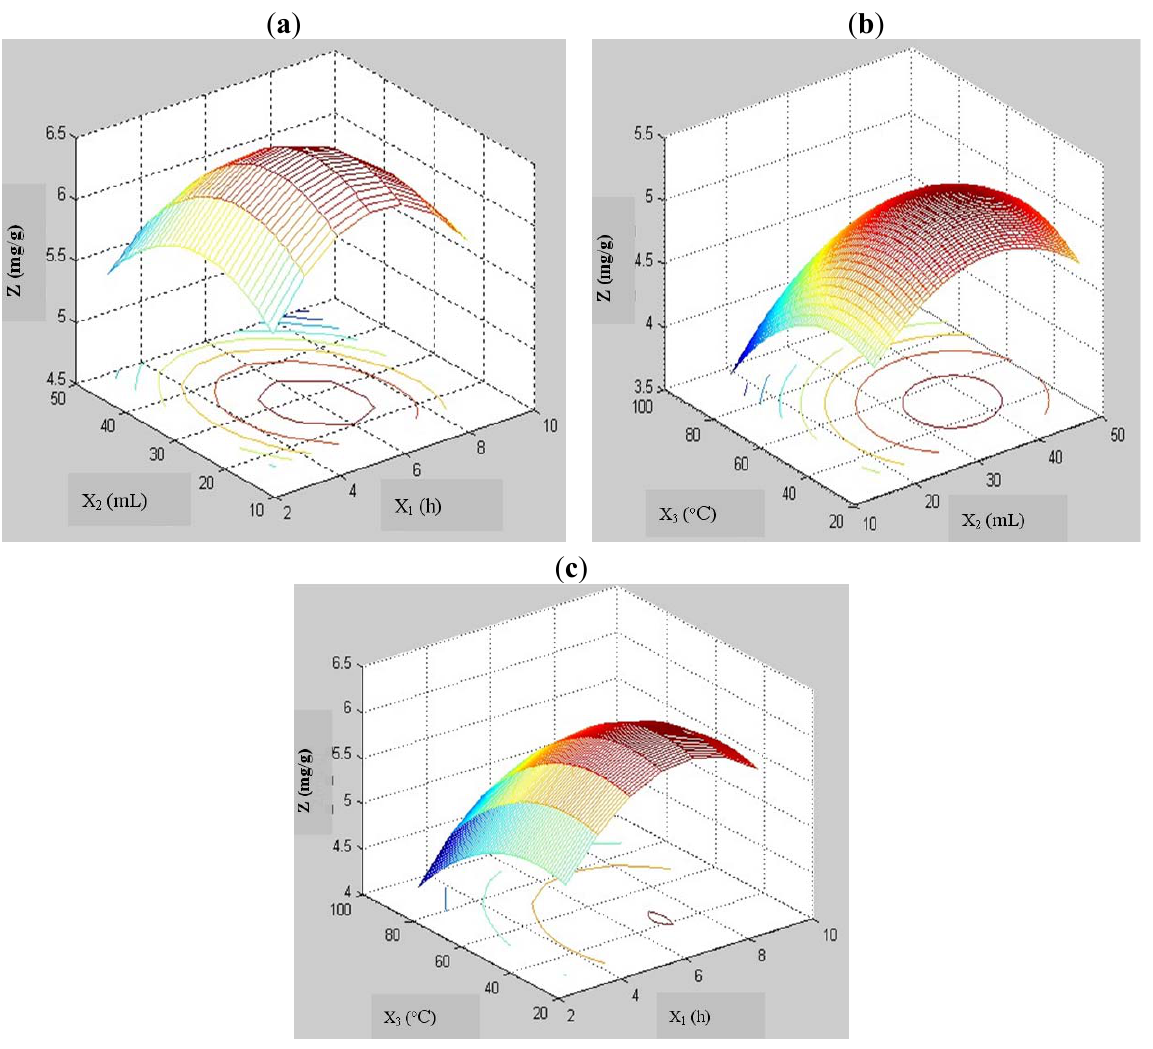
Figure 1. Three-dimensional figures of interactive effects of heating time (X ), enzyme 1 quantity (X ) and temperature (X ) on extraction yield (Z). ( a ) Interactive effects of heating 2 3 time (X ) and enzyme quantity (X ) on extraction yield (Z) at a fixed temperature; 1 2 ( b ) interactive effects of enzyme quantity (X ) and temperature (X ) on extraction yield (Z) 2 3 at a fixed heating time; ( c ) interactive effects of heating time (X ) and temperature (X ) on 1 3 extraction yield (Z) at a fixed enzyme